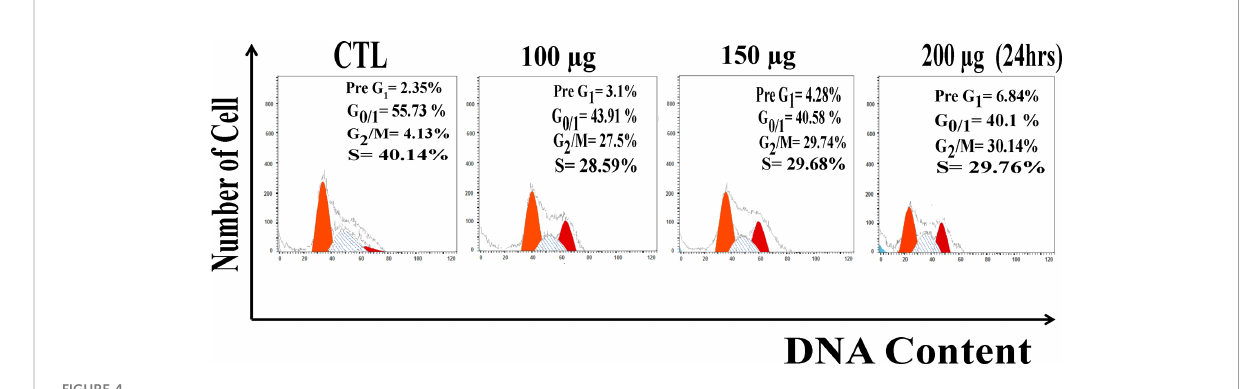
FIGURE 4 DNA content analysis HuH7 cell line treated with of ZnO